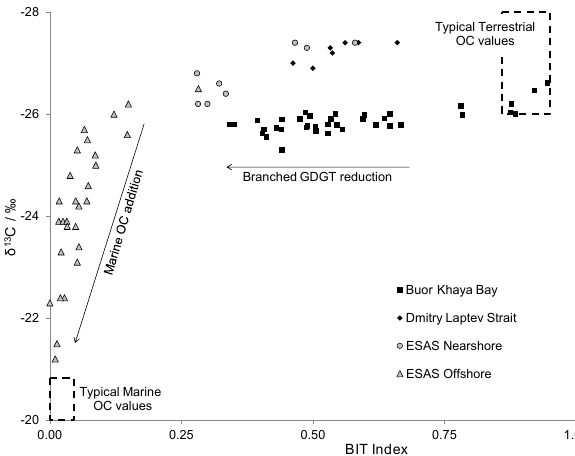
Figure 6. Plot of δ 13 C vs. BIT index. Typical values for terrestrial and marine endmember samples are shown (Hopmans et al., 2004; Vonk et al., 2012). Note the non-linearity of the relationship; the BIT index drops significantly before a shift in isotope ratio to more marine